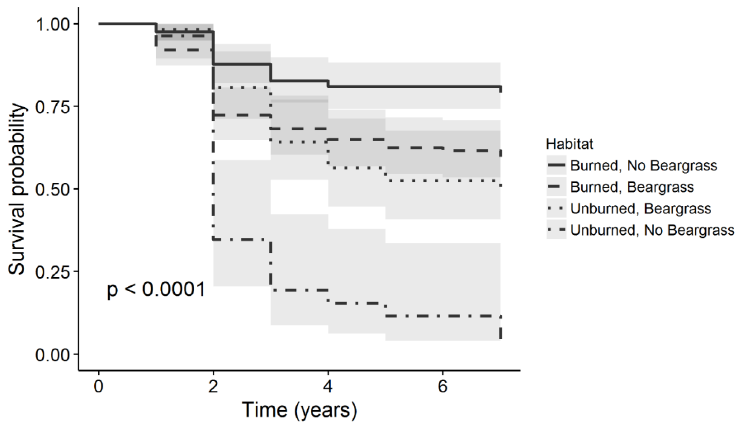
Figure 3. Cluster survival for four habitat treatment types: Burn and beargrass, burn and no beargrass, unburned and beargrass, and unburned and no beargrass ( X 2 (3, n = 331) = 64.8, p ˂ 0.0001) over seven years.